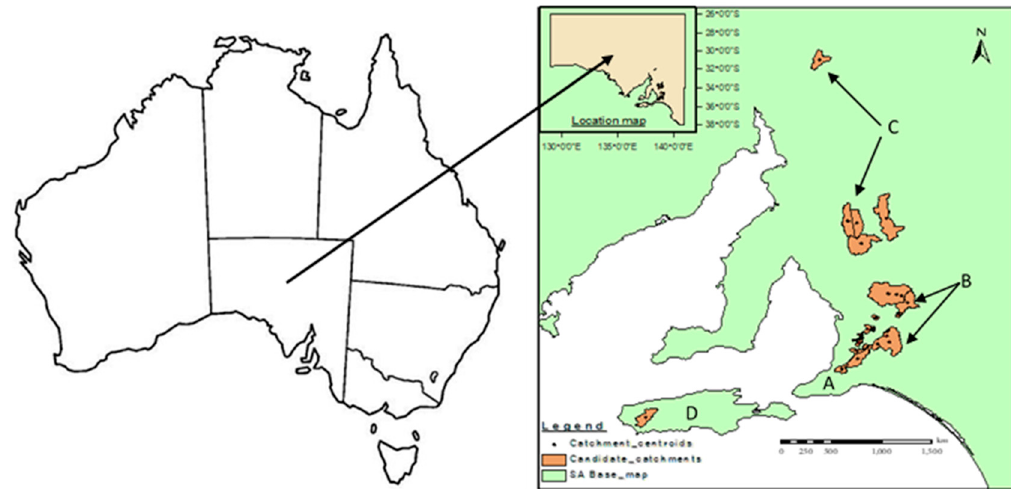
Figure 1. Geographical locations of the drainage basins considered in the current study.